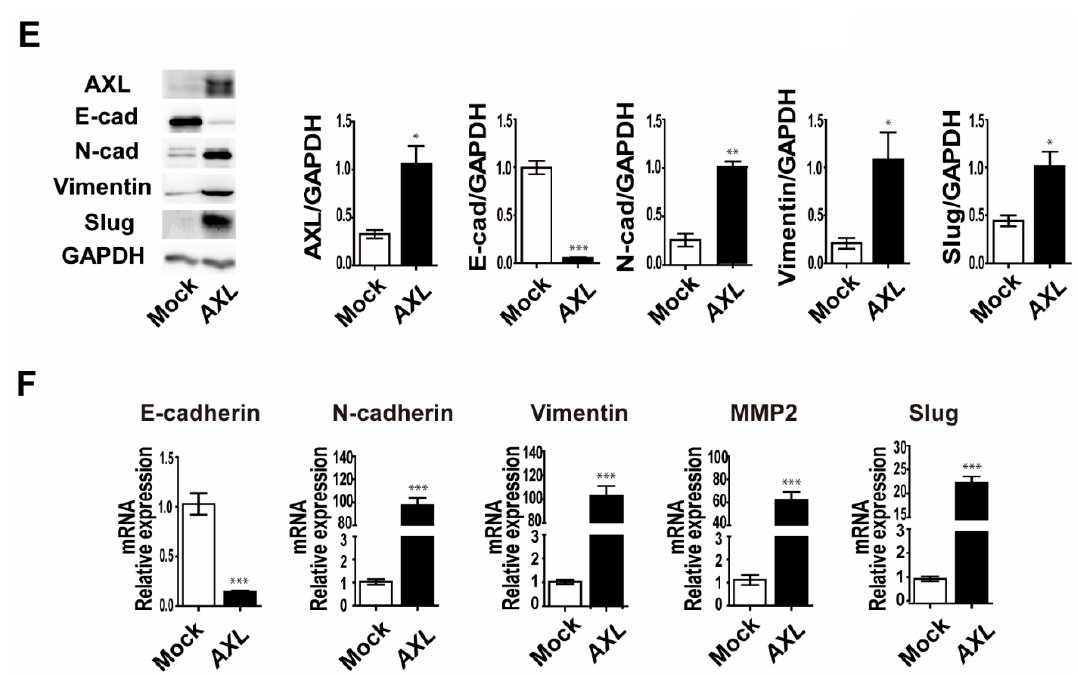
Figure 4. Overexpression of AXL induces vasculogenic mimicry formation and regulates epithelial–mesenchymal transition (EMT) marker expression in MCF-7 breast cancer cells. ( A ) AXL protein and ( B ) mRNA expression in MCF-7 breast cancer cells and MCF-7/AXL stable cells. ( C ) Development of VM due to AXL overexpression in MCF-7 breast cancer cells. ( D ) Enhanced invasion ability in MCF-7/AXL stable cells. ( E ) EMT marker protein and ( F ) mRNA expression in MCF-7/AXL stable cells. * p < 0.05, ** p < 0.01, *** p < 0.001 versus controls, calculated using unpaired two-tailed Student’s t -test. Error bars, S.E.M.